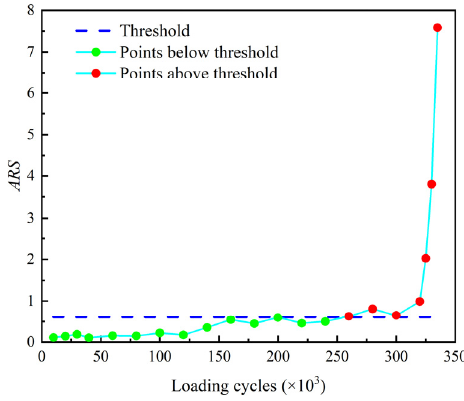
Figure 27. Accumulative residual squares ARS of filtered echo signal.